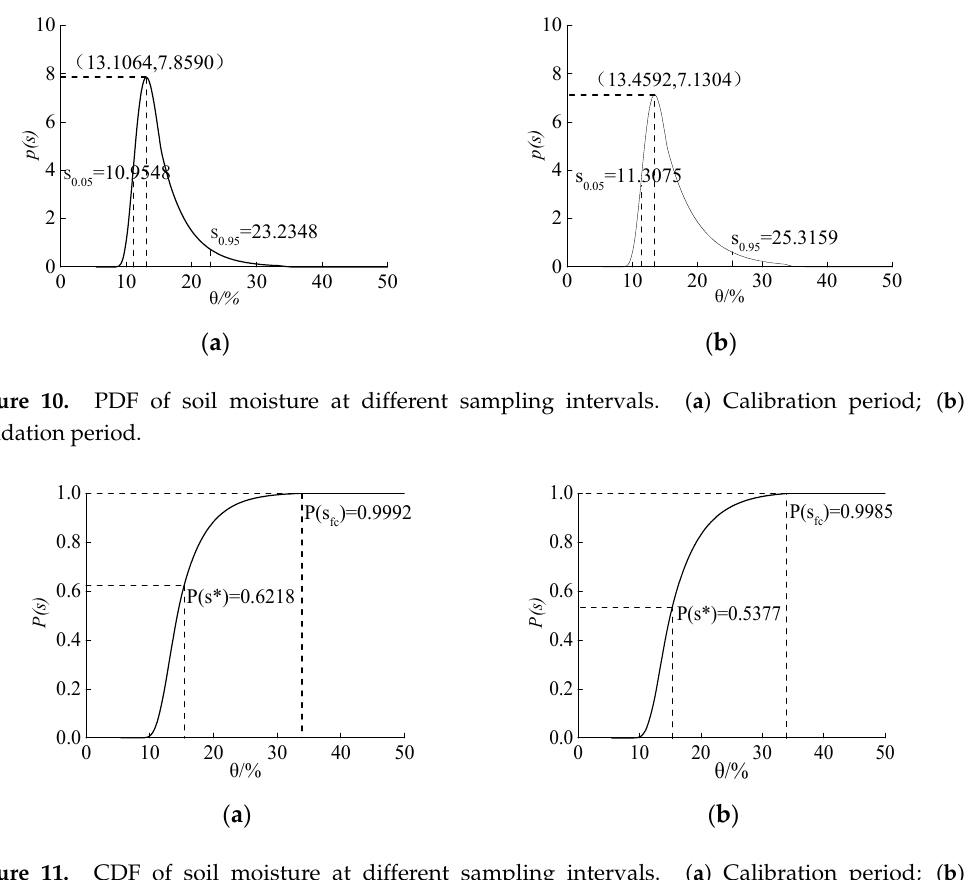
Figure 11. CDF of soil moisture at different sampling intervals. ( a ) Calibration period; ( b ) Validation period.